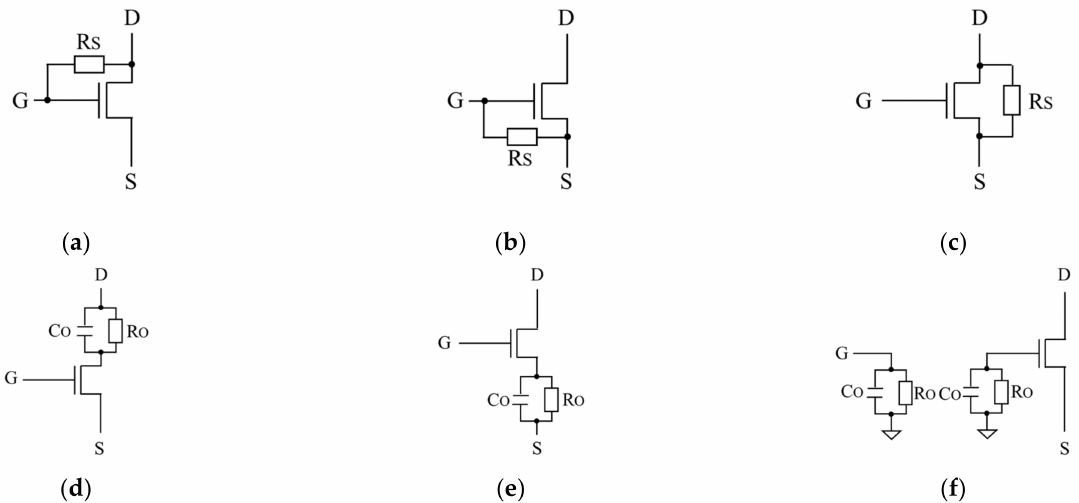
Figure 5. The six fault models in this paper ( a ) gate-drain short (GDS); ( b ) gate-source short (GSS); ( c ) drain-source short (DSS); ( d ) drain open (DO); ( e ) source open (SO); ( f ) gate open (GO).